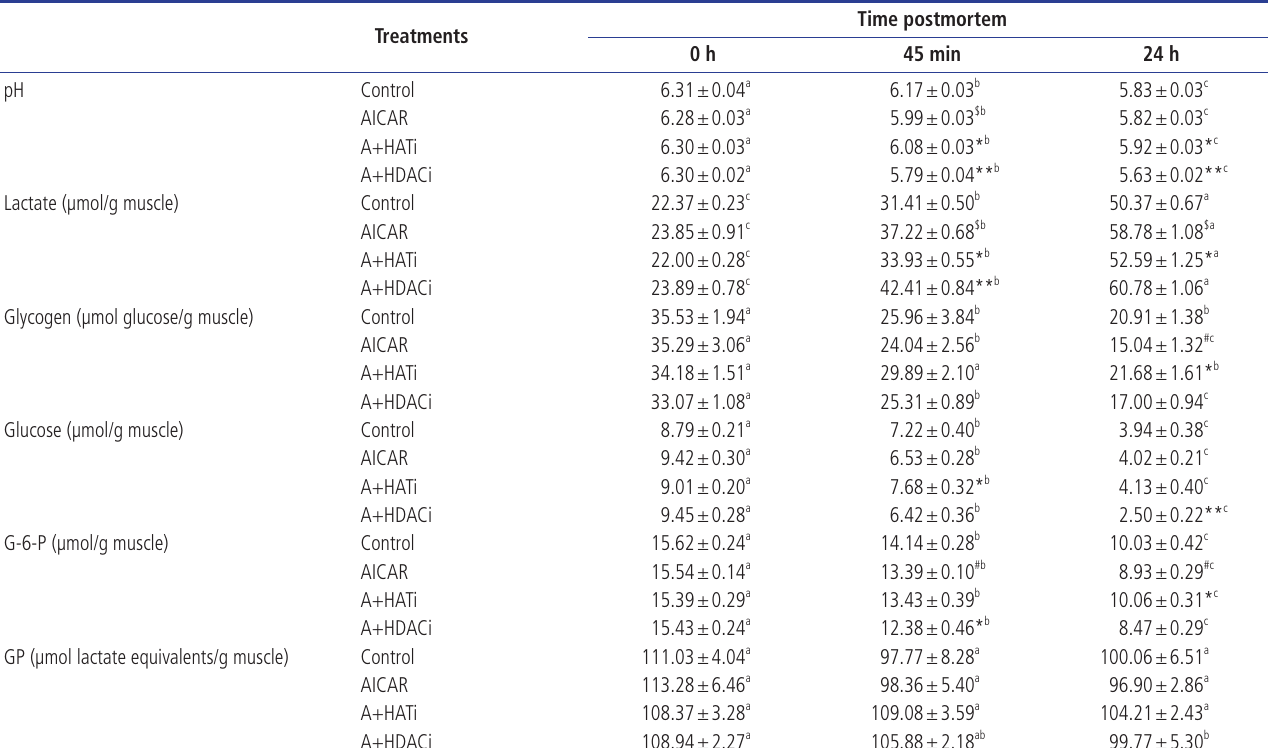
Table 1. Determined pH values, lactate, glycogen, glucose, glucose-6-phosphate, and calculated glycolytic potential in postmortem LD muscle from mice injected with or without AICAR, HAT, or HDAC